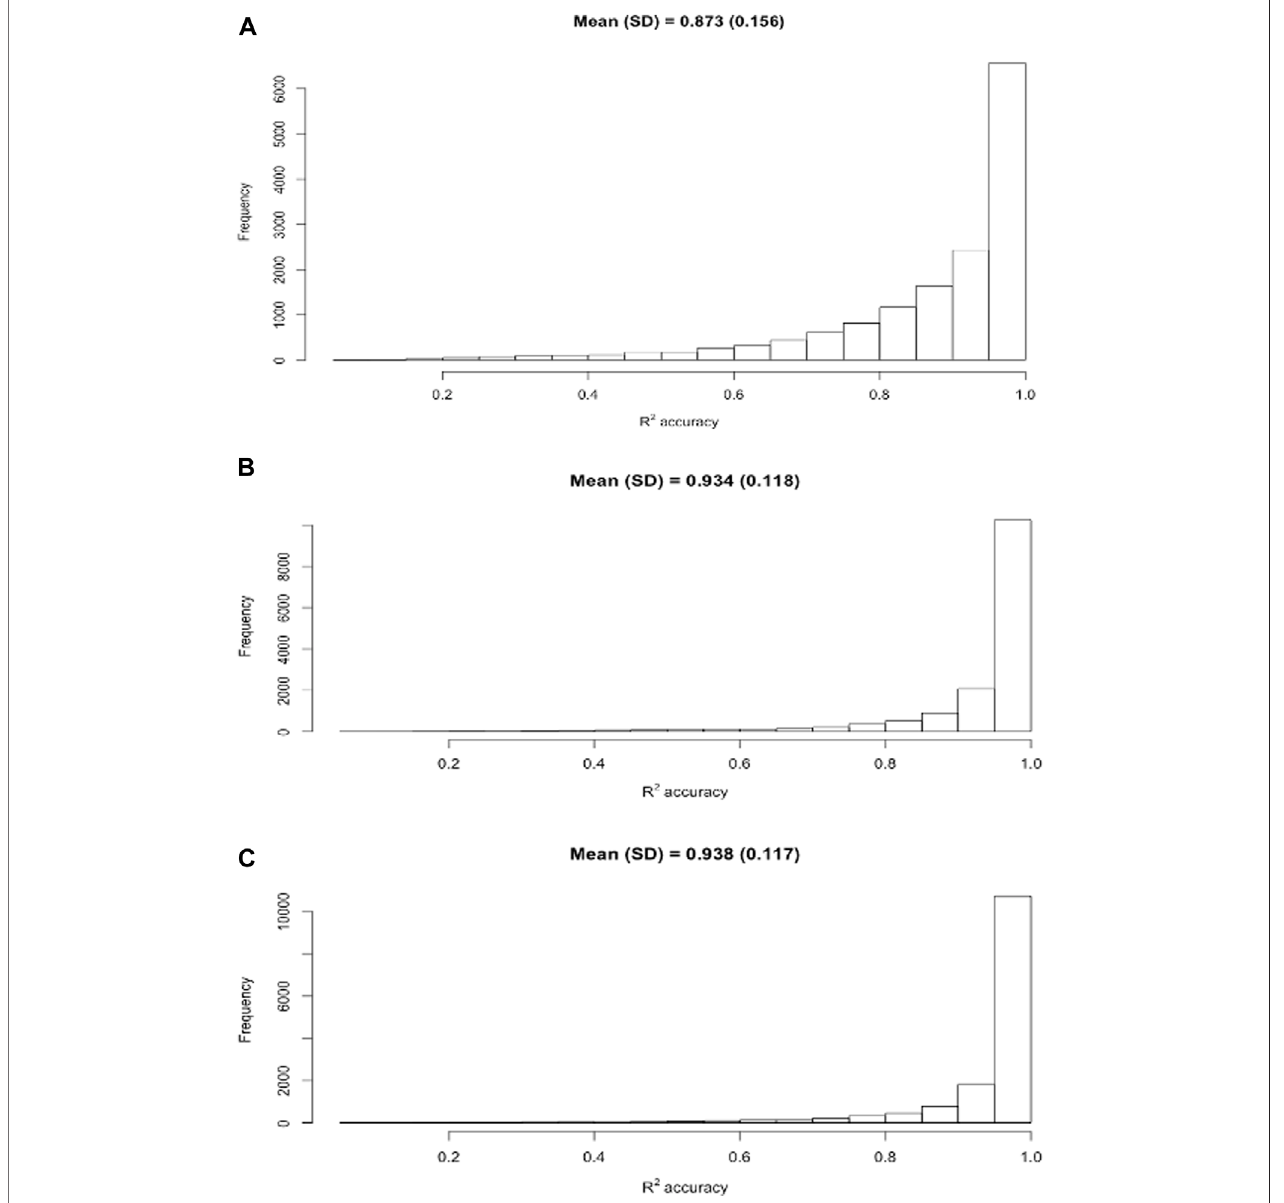
FIGURE 3 | Distribution of individual R 2 accuracies of the estimated daily milk yield obtained using three models, M0 (A) , M2B (B) , and M7B (C) , respectively. M0=twotimes AMorPMyieldastheestimateoftest-daymilkyield; M2B=additivecorrectionfactormodelimplemented byregressingthedifferencebetweenAMand PM yields on milking interval and days in milk; M7B = multiplicative correction factor model according to Wiggans (1986).